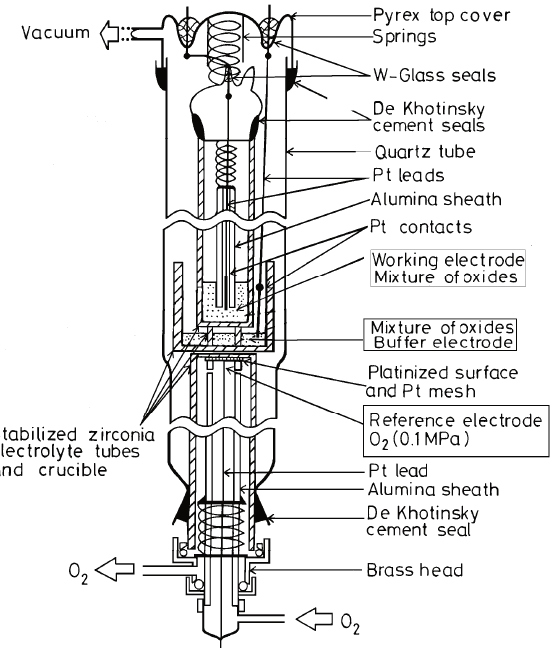
Figure 1. Schematic diagram of the apparatus used for oxy- gen chemical potential measurements in three biphasic regions of the system Mn-O. The solid-state electrochemi- cal cell has a buffer electrode that prevents polarization of the measuring